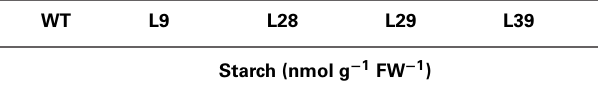
Table 2 | Starch content in the B33-PPi red tomato fruits (60 DAP). WT L9 L28